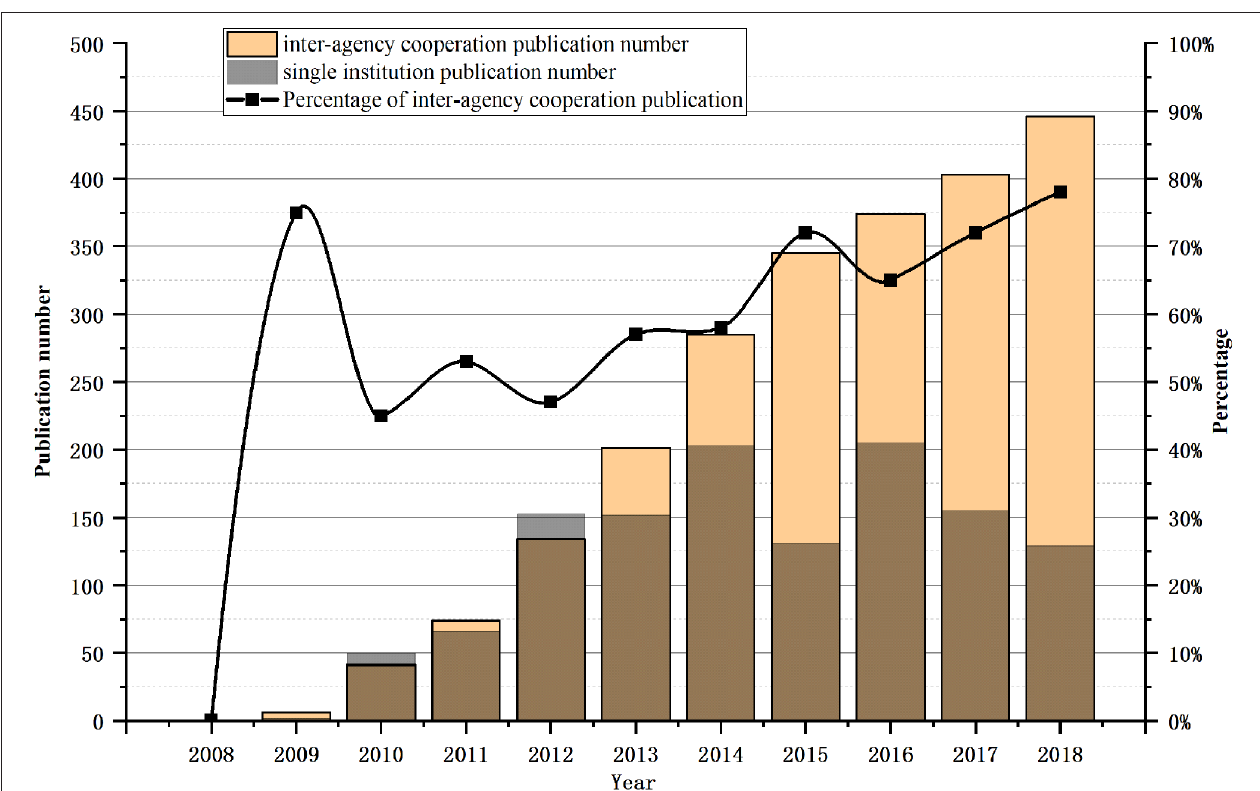
FIGURE 5 | Annual literature distribution of inter-agency and single